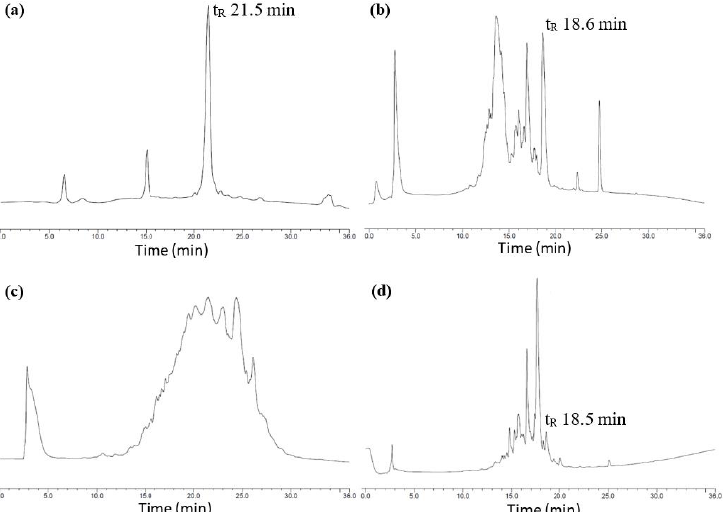
Figure 3. RP-HPLC chromatograms (214 nm) monitoring key intermediates during on-resin preparation of linear cathelicidin-PY ( 12 ) under microwave irradiation according to Scheme 1a. ( a ) confirms the desired product Fmoc-protected linear cathelicidin-PY 20 − 29 (t R = 21.5 min) ( b ) confirms the desired product Fmoc-protected linear cathelicidin-PY 10 − 29 (t R = 18.6 min) ( c ) the desired product, linear cathelicidin-PY ( 12 ), was not present ( d ) confirms the presence of the desired linear cathelicidin-PY ( 12 ) (t R = 18.5 min) under automated synthetic conditions according to Scheme 1b.